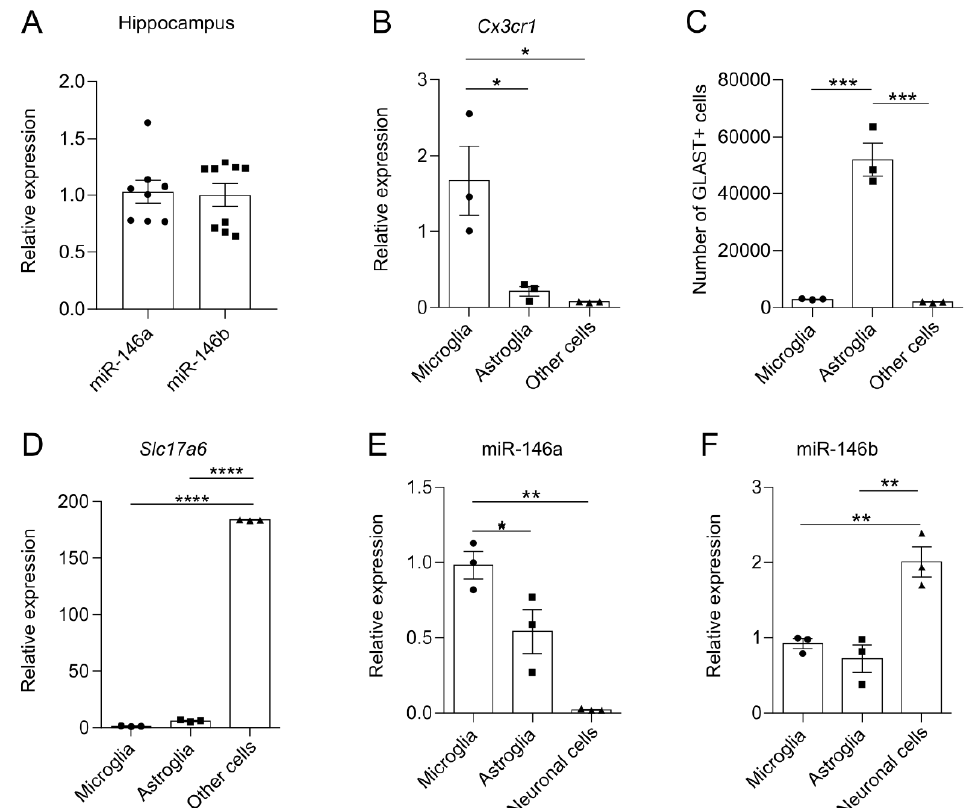
Figure 1. Expression of miR-146a and miR-146b in hippocampus and cellular fractions isolated from WT mice. ( A ) Quantification of miR-146a/b expression in the hippocampus of WT mice. Number of animals in ( A ) = 8–9, Student’s t -test. ( B – D ) Characteristics of the cellular fractions isolated from the WT mouse brain. ( B ) Relative mRNA expression of microglial Cx3cr1 . ( C ) Number of astroglial marker GLAST+ cells (determined by flow cytometry). ( D ) Relative expression of neuronal marker Slc17a6 mRNA levels. As fraction of “other cells” abundantly expressed neuronal marker Slc17a6 mRNA, this fraction was named as neuronal cells. ( E ) Quantification of miR-146a and ( F ) miR-146b in microglia, astroglia and neuronal cells of WT mice. Number of cell batches in experiments ( B – F ) = 3, one-way ANOVA followed by Tukey’s multiple comparison test. Data represented as mean ± SEM; * p < 0.05, ** p < 0.01, *** p < 0.001, **** p < 0.0001.